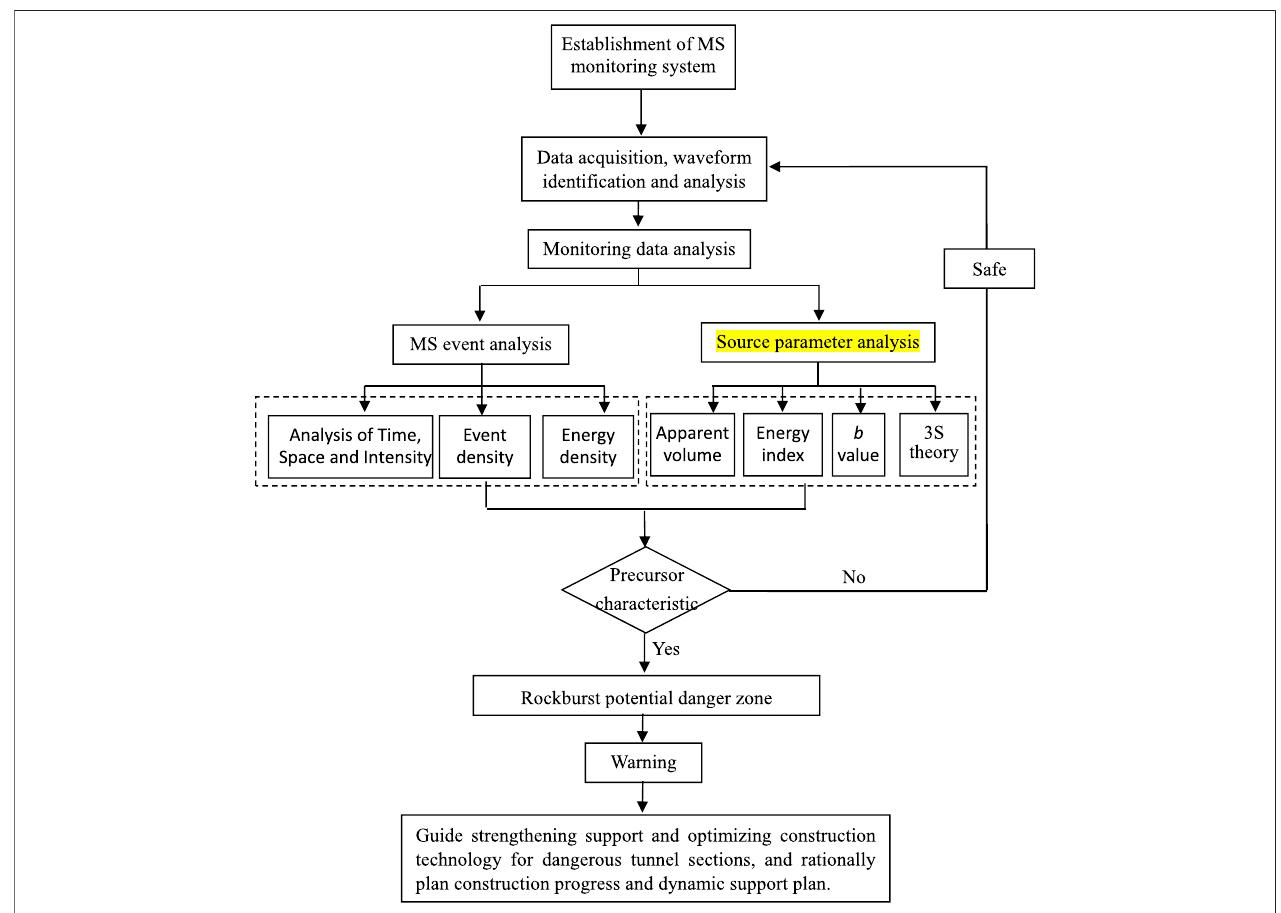
FIGURE 8 | Flow chart of early warning for rockburst in deep-buried tunnel at Jinping project.